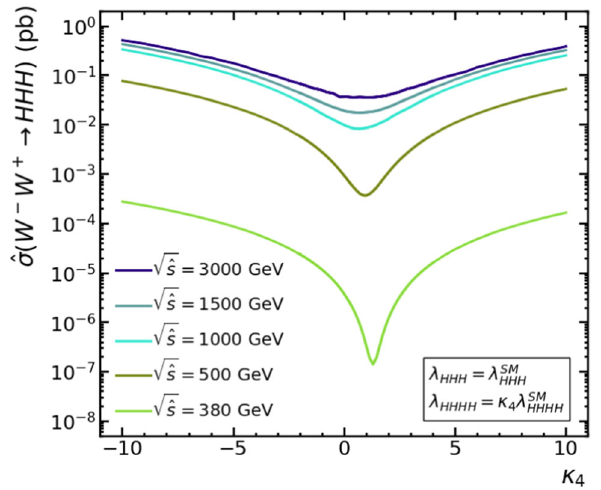
Fig. 17 Total cross section of the W − W + → H H H subprocess as a function of κ 4 (with κ 3 fixed to 1) for different values of the CM energy √ ˆ s parameter values considered here, i.e. κ 3 , 4 ∈ [− 10 , 10 ] and